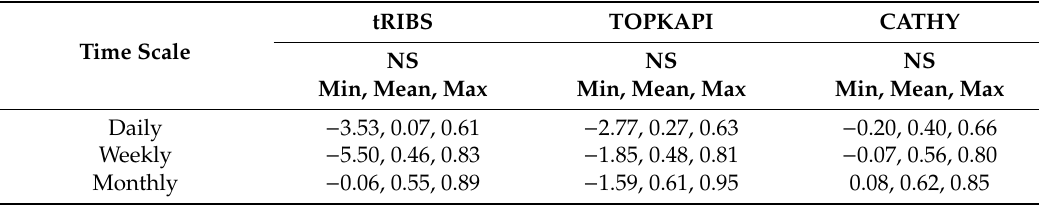
Table 6. Minimum, mean, and maximum Nash-Sutcli ff e index (NS) for the 1930 simulation period (calibration period for tRIBS), evaluated using the observed and simulated water volume of the 50 ensemble members at daily, weekly, and monthly time scales for the three hydrologic